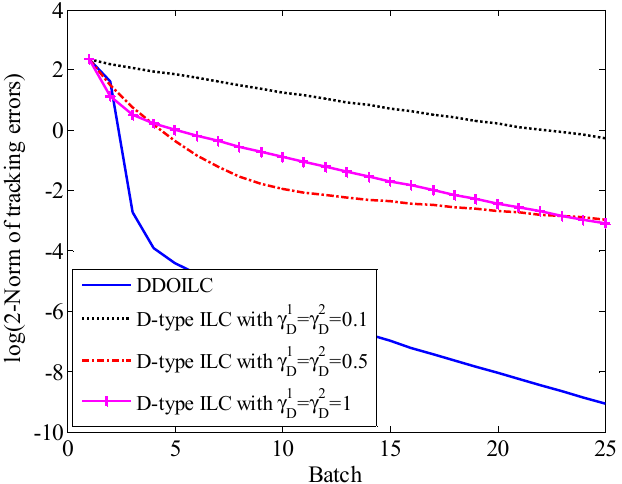
Figure 7. Accurate comparison of the DDOILC with the D-type ILC.